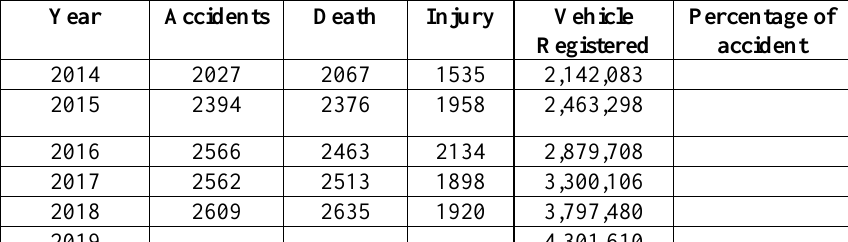
Table 2: Time series data on road accidents and fatalities.